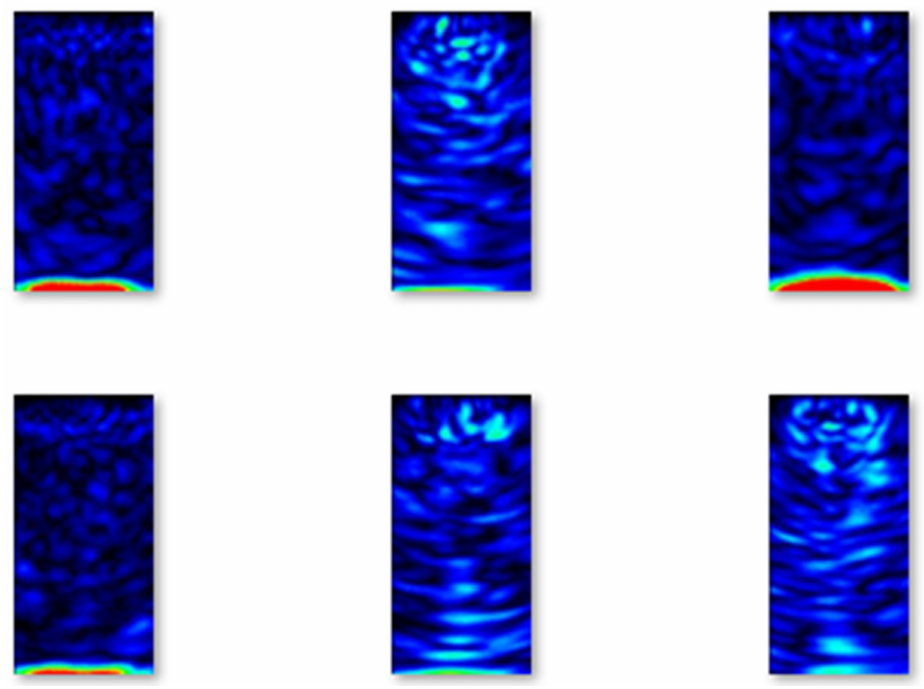
Figure 9. Examples of B-scans without flaws from the testing set.